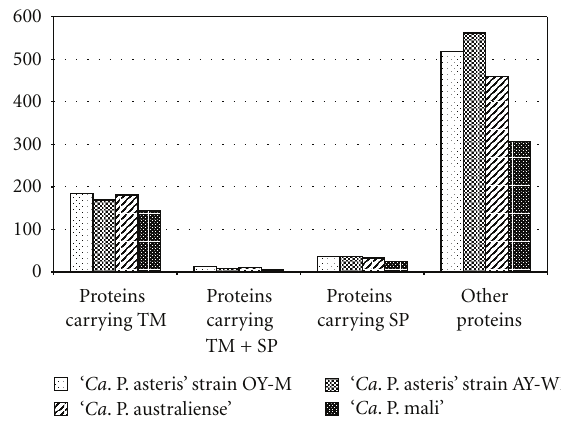
Figure 5: Phobius predictions of the four phytoplasma